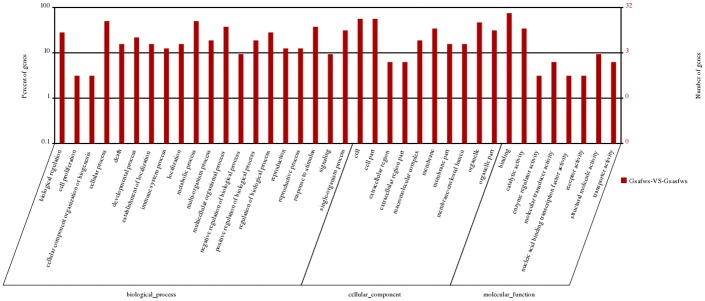
GO functional analysis of DEGs and NATs.The results were summarized in three main categories: biological process, cellular component and molecular function. Among these groups, the terms binding, cell part and metabolic process were dominant in each of the three main categories, respectively.